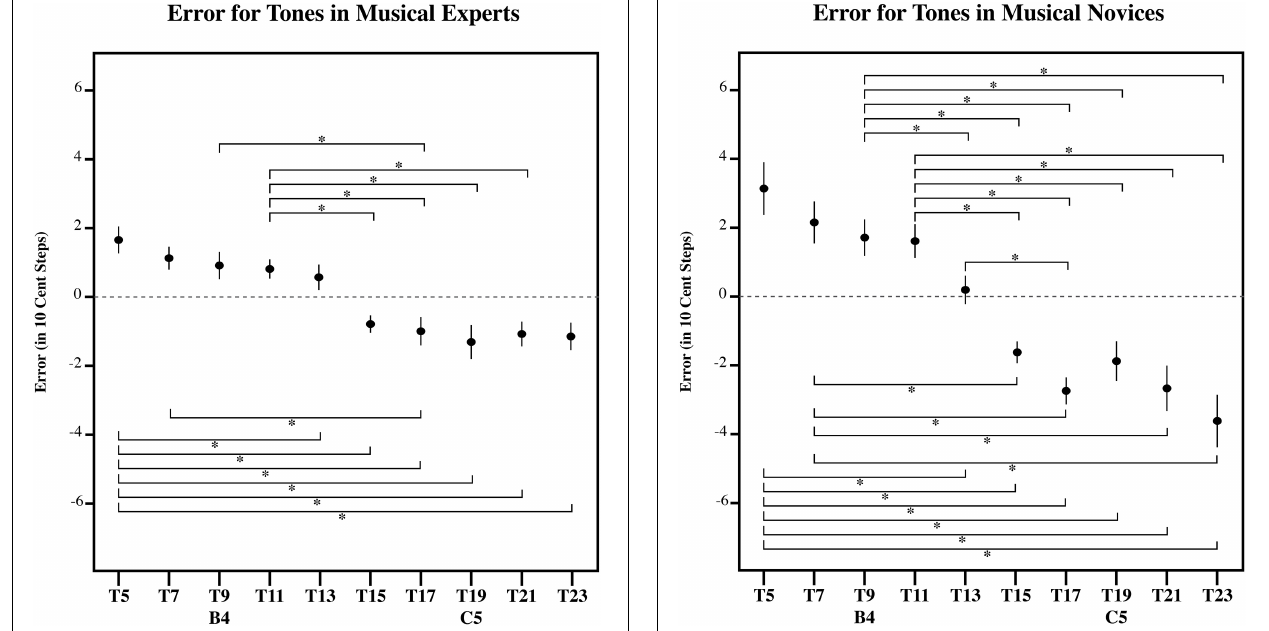
FIGURE 9 | The error in 10-cent steps for each tone in ME. Significant pairwise comparisons (alpha 0.05) using a Sidak adjustment are indicated with an asterisk. Note that ME bisect the presented distribution at its midpoint, such that lower tones in the series are overestimated and higher tones in the series are underestimated. However, note that ME ( Figure 9 ), along with AP possessors ( Figure 8 ) have flatter error patterns than MN ( Figure 10 ) and the RGD ( Figure 11 ). Error bars represent ± 1 s.e.m.